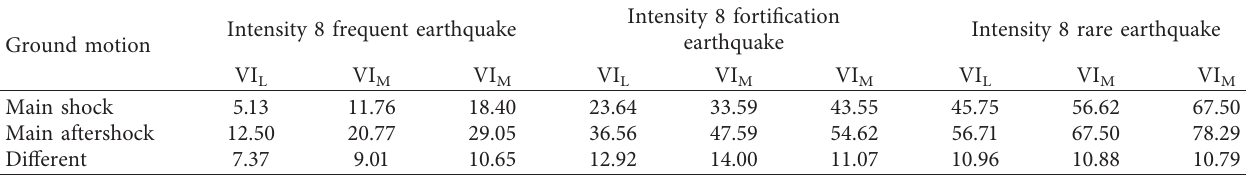
Figure 18: Vulnerability index curves. (a) Main shock. (b) Main aftershock. (c) Difference value. Table 15: Lower limit, mean and upper limit values of the vulnerability index